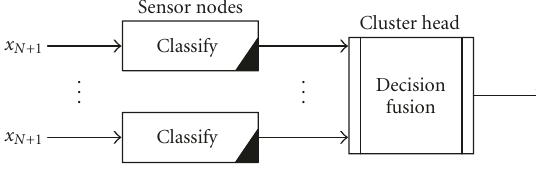
Figure 4: Decision fusion at cluster head